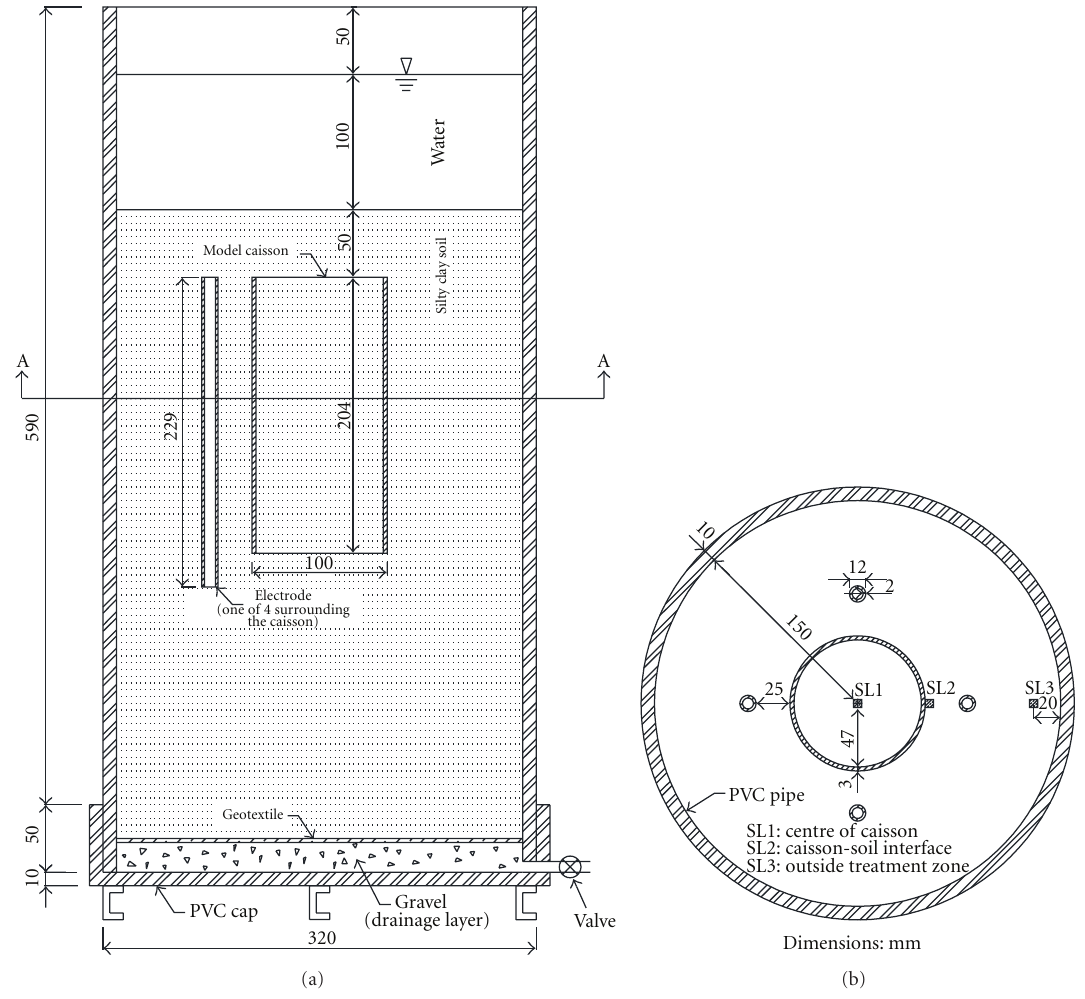
Figure 1: (a) Schematic of electrokinetic treatment cell; (b) Cross-section A-A (test 3 model caisson and configuration).